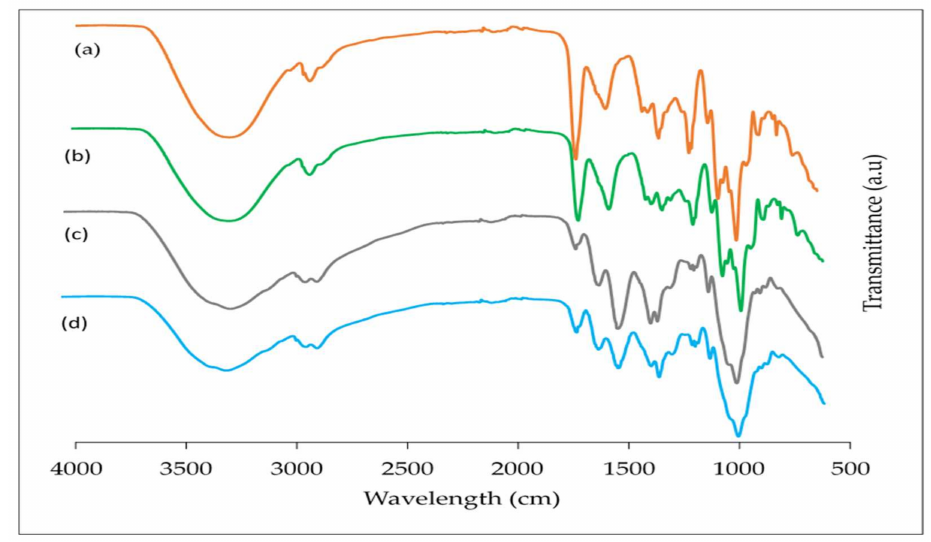
Figure 6. FTIR spectra of pure pectin ( a ), chitosan films ( c ) and bilayer films from both sides (( b) and ( d )).